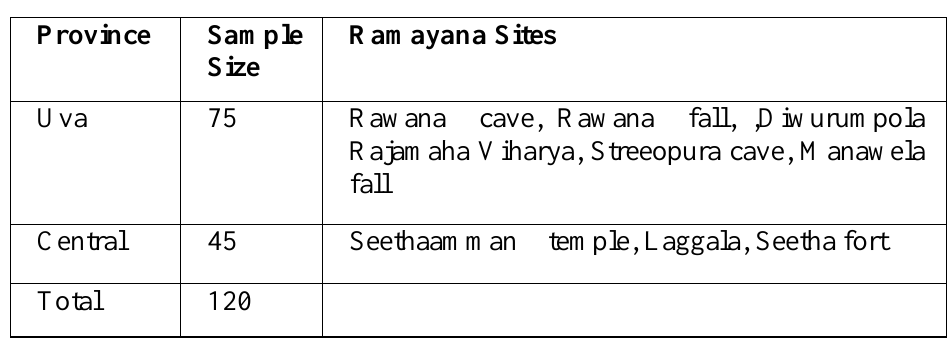
Table 1: Sampling